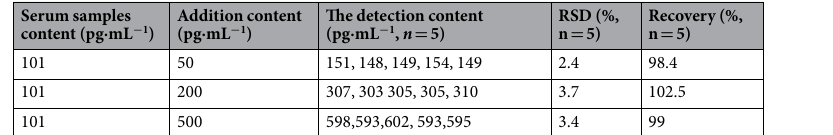
Table 1. Results for the detection of PSA in serum